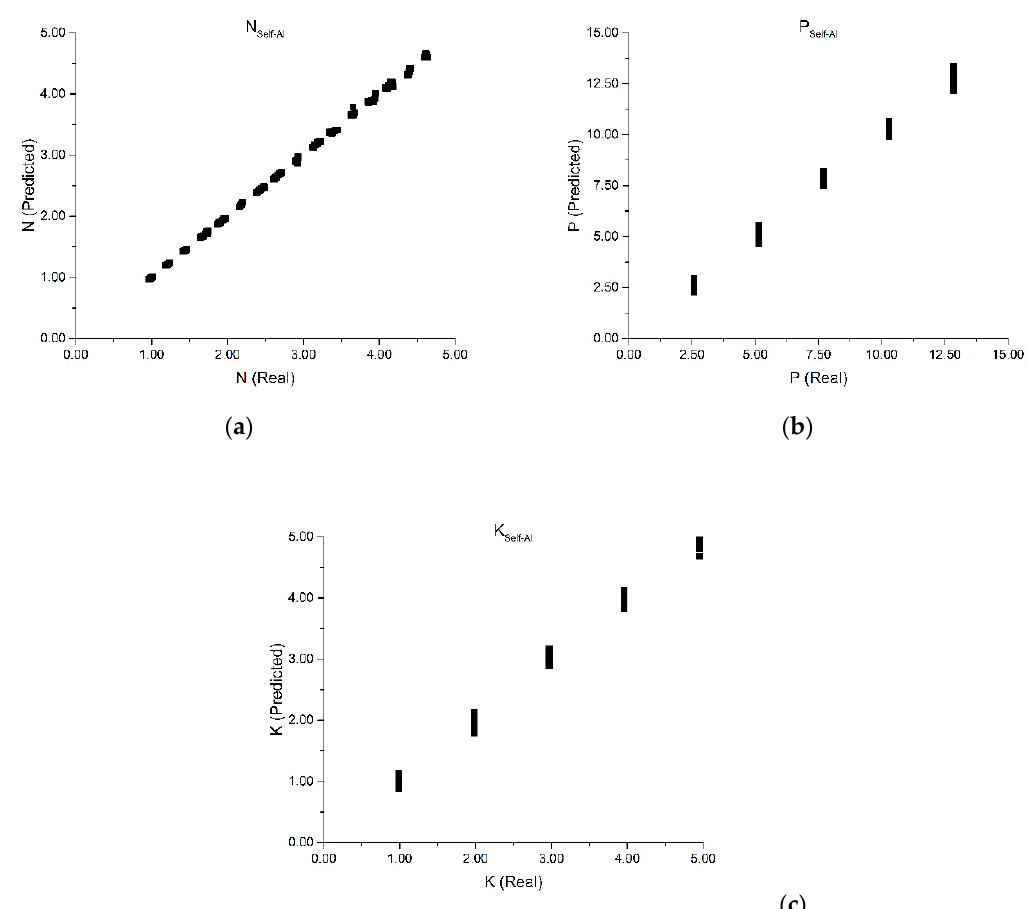
Figure 8. Self-learning AI prediction for total nitrogen ( a ) total phosphorus ( b ) and potassium ( c ).